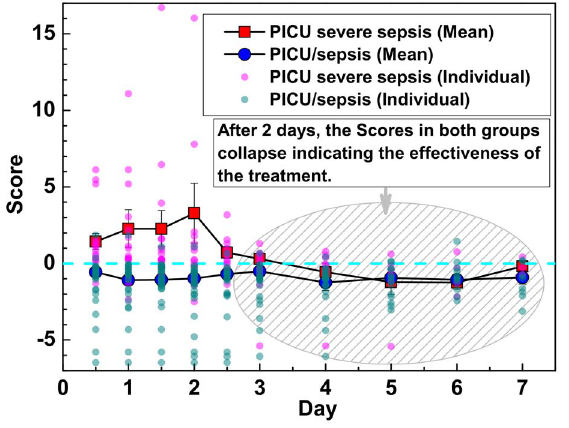
Figure 5. Measures of the biomarker importance obtained from the Random Forests method. Mean Decrease in Accuracy (MDA) are shown for biomarkers in (A) without Ang-2/Ang-1 and (B) with Ang-2/Ang-1 using the Random Forests method with 1,000 trees for each.